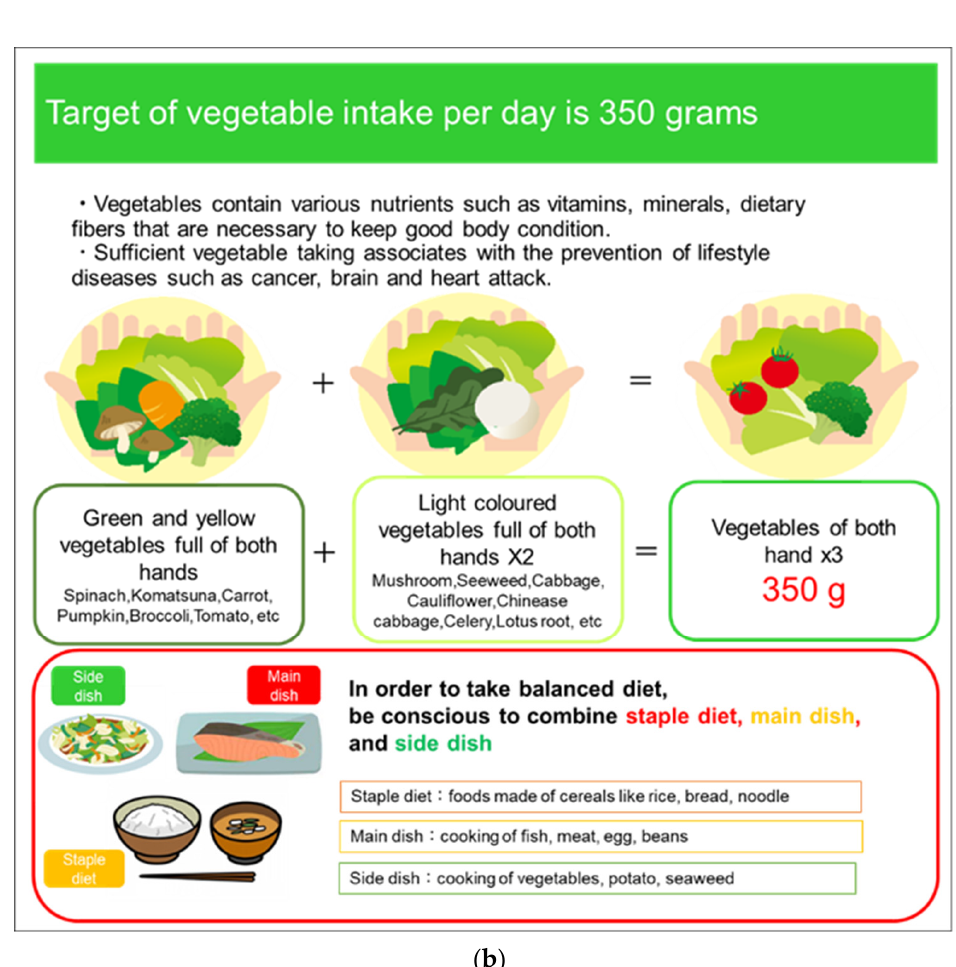
Figure 1. ( a ) A report used to inform the results. ( b ). A flyer describing the amount of vegetables and the importance of balanced diet. The original paper was written in Japanese.